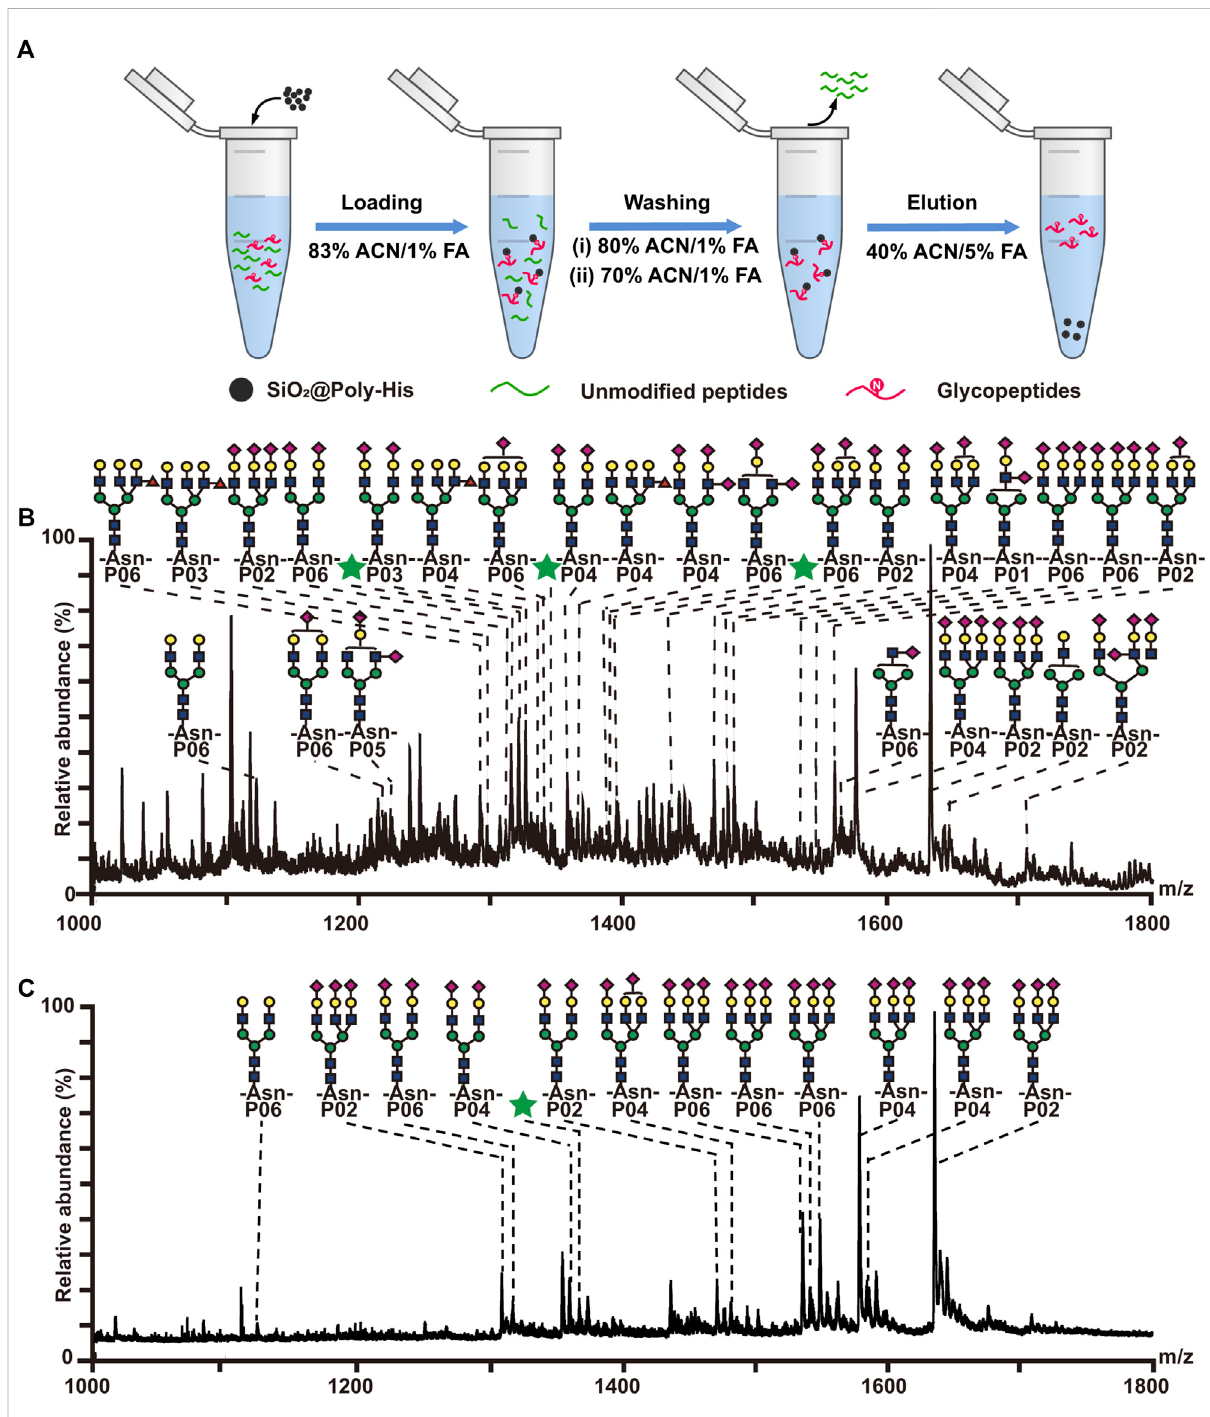
FIGURE 2 Enrichment of glycopeptides with SiO 2 @Poly-His microspheres and commercial ZIC-HILIC materials. (A) Work fl ow for the glycopeptide enrichment with the SiO 2 @Poly-His microspheres; (B) Mass spectrum of the mixture of the bovine fetuin and BSA at molar ratio of 1:5,000 enriched by SiO 2 @Poly-His microspheres; (C) Mass spectrum of the mixture of the bovine fetuin and BSA at molar ratio of 1:5,000 enriched by